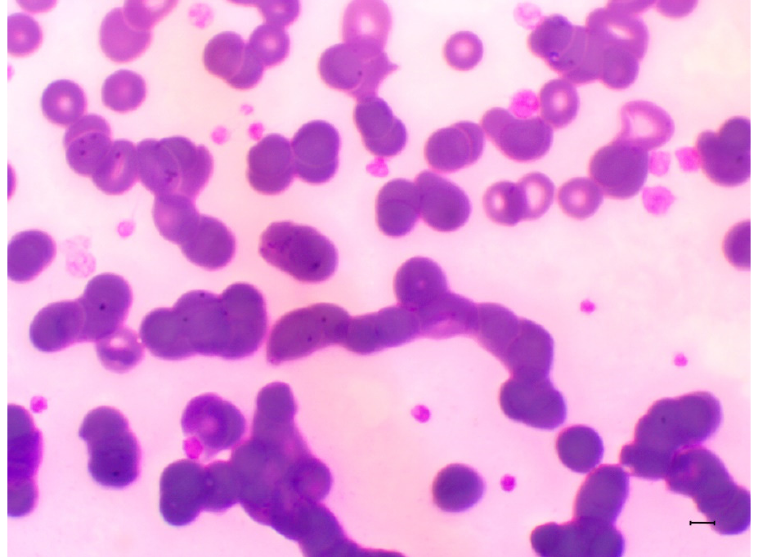
Figure 3. Light microscopy image of Romanowsky-type-stained peripheral blood smear from black- eared opossum ( Didelphis aurita ), showing small basophilic and round structures attached to erythrocytes (arrows). Sample from adult female black-eared opossum (1000× magnification). Bar = 10 μ m.